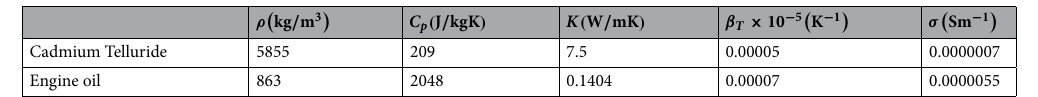
Table 2. Thermo-mechanical characteristics of engine oil and cadmium telluride nanoparticles 39 .